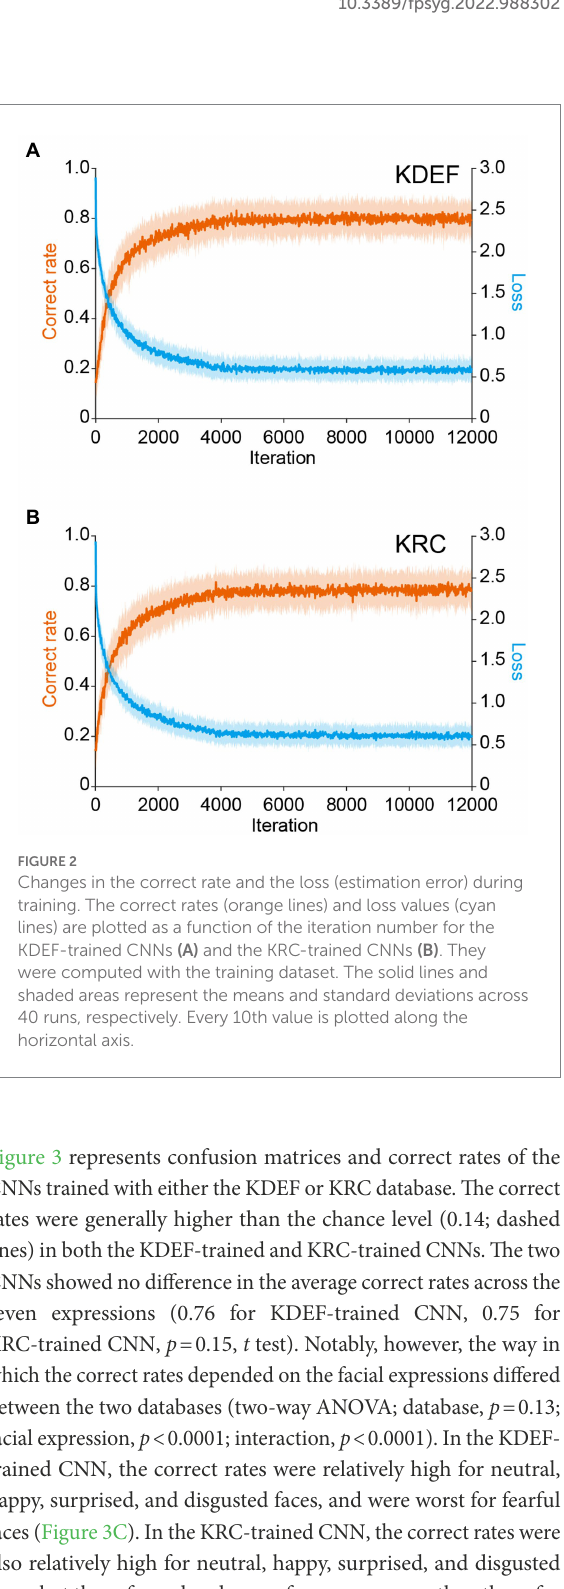
Figure 3 represents confusion matrices and correct rates of the CNNs trained with either the KDEF or KRC database. The correct rates were generally higher than the chance level (0.14; dashed lines) in both the KDEF-trained and KRC-trained CNNs. The two CNNs showed no difference in the average correct rates across the seven expressions (0.76 for KDEF-trained CNN, 0.75 for KRC-trained CNN, p = 0.15, t test). Notably, however, the way in which the correct rates depended on the facial expressions differed between the two databases (two-way ANOVA; database, p = 0.13; facial expression, p < 0.0001; interaction, p < 0.0001). In the KDEF- trained CNN, the correct rates were relatively high for neutral, happy, surprised, and disgusted faces, and were worst for fearful faces (Figure 3C). In the KRC-trained CNN, the correct rates were also relatively high for neutral, happy, surprised, and disgusted faces, but those for sad and angry faces were worse than those for fearful faces (Figure 3D). The high correct rates of neutral, happy, surprised, and disgusted faces suggest that facial features are consistent across exemplars of these facial expressions within each database. By contrast, fearful faces in KDEF and angry faces in KRC may be more diverse in their appearance than the other facial expressions.